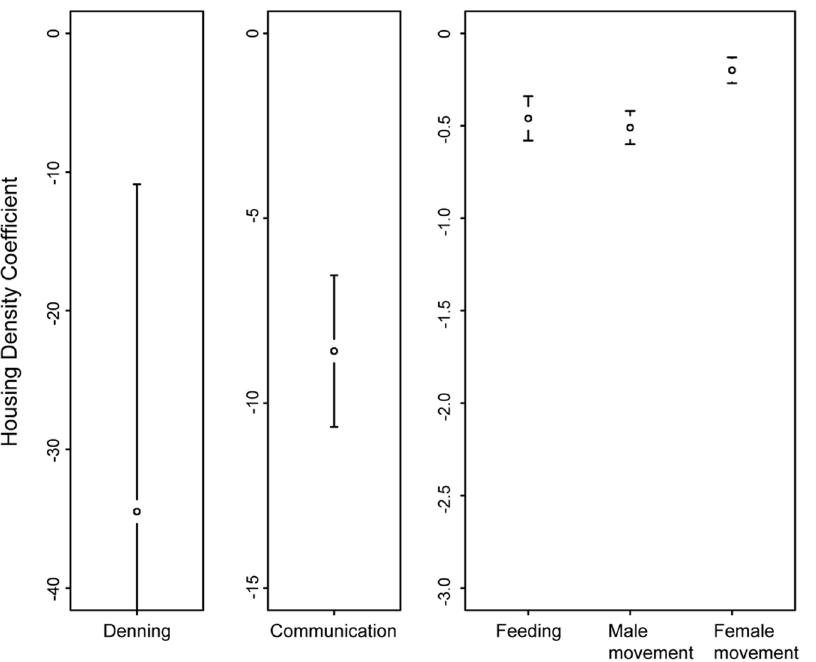
Figure 2. Relative sensitivities of each behavior to housing density as indicated by the fixed regression coefficient ( ± s.e.) of housing density in each behavioral model. These represent the relative log odds of pumas exhibiting each behavior for a unit change in normalized housing density holding other covariates constant. Note the difference in the y-axis scale among panels.